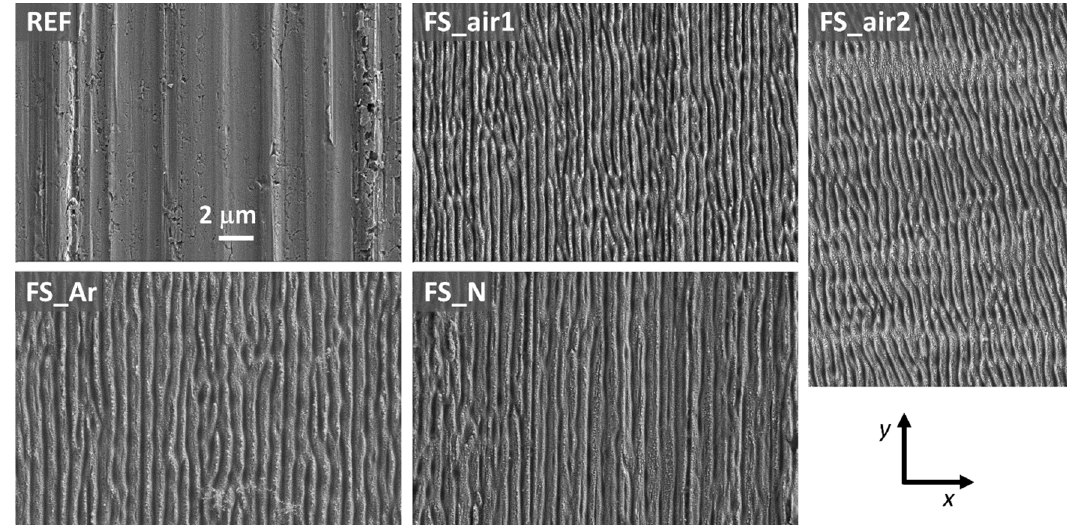
Figure 1. FE-SEM micrographs (secondary electrons) of the surfaces of all analyzed representative samples (same magnification for all images). The rolling direction is parallel to the y -axis in all samples, except for FS_air2, where it is parallel to x . The linear laser beam polarization is parallel to x in all cases.